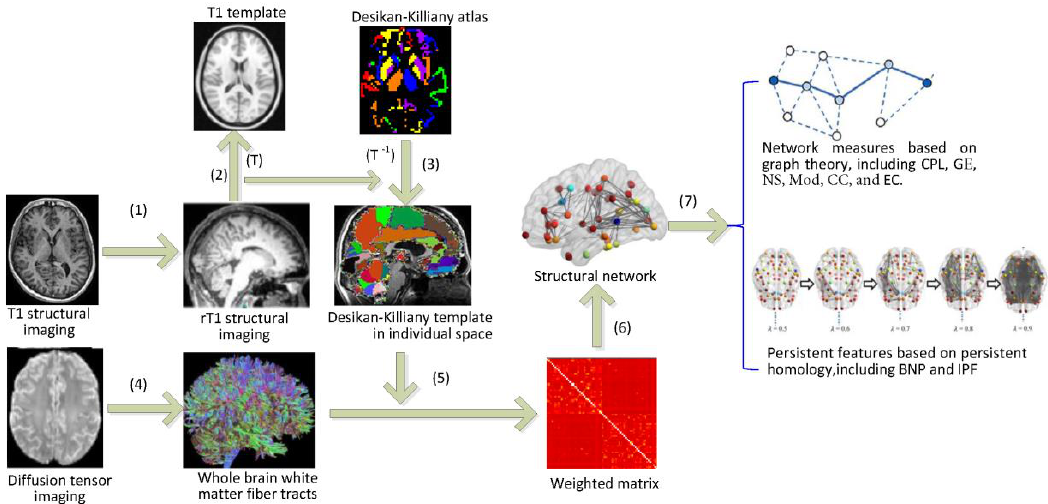
Figure 5. The workflow of brain network analysis based on graph theory and persistent homology.